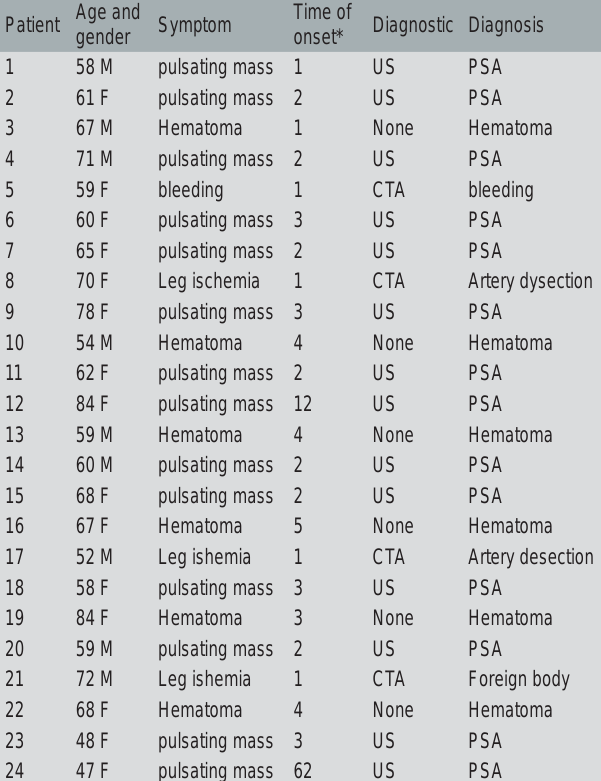
TABLE 2. Cumulative results of detected vascular